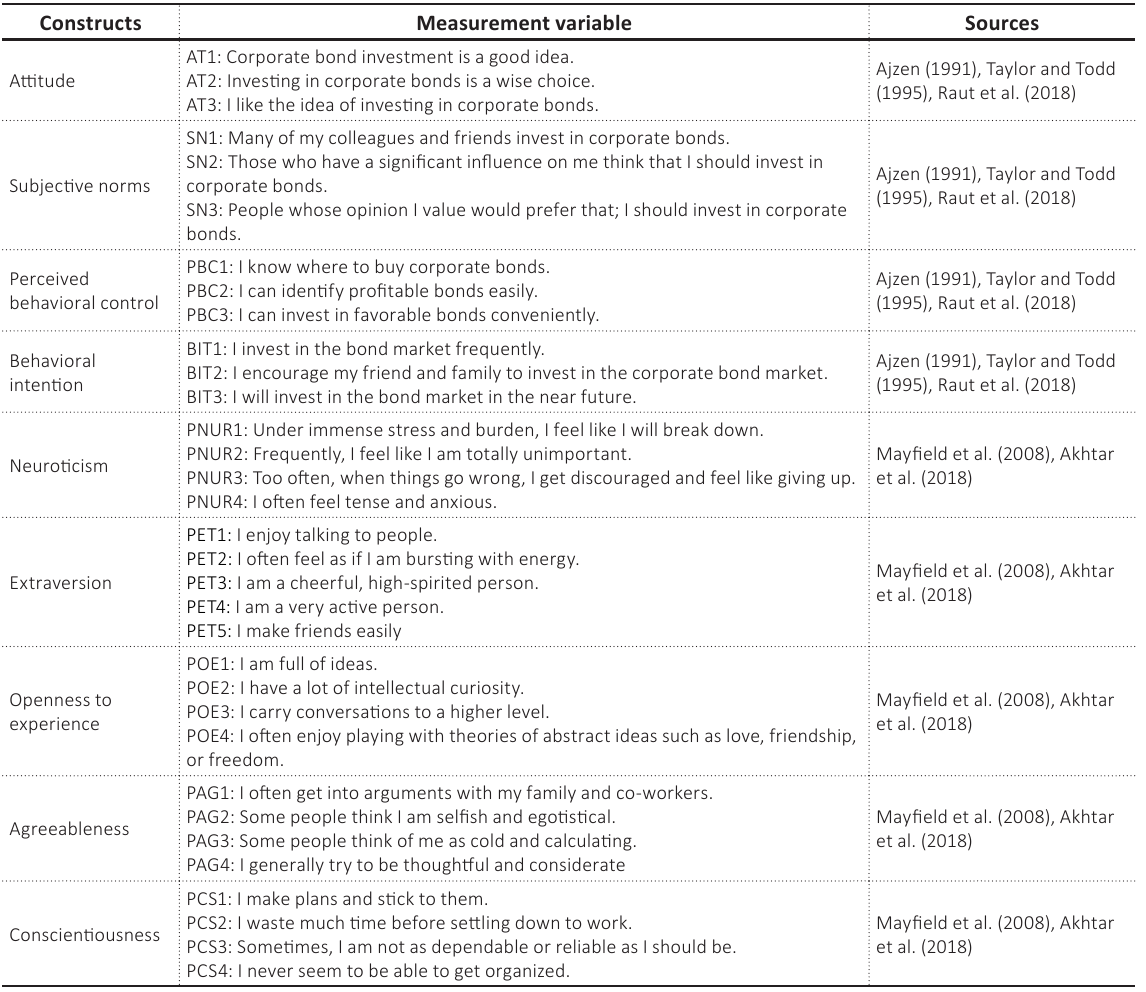
Table 1. Measurement